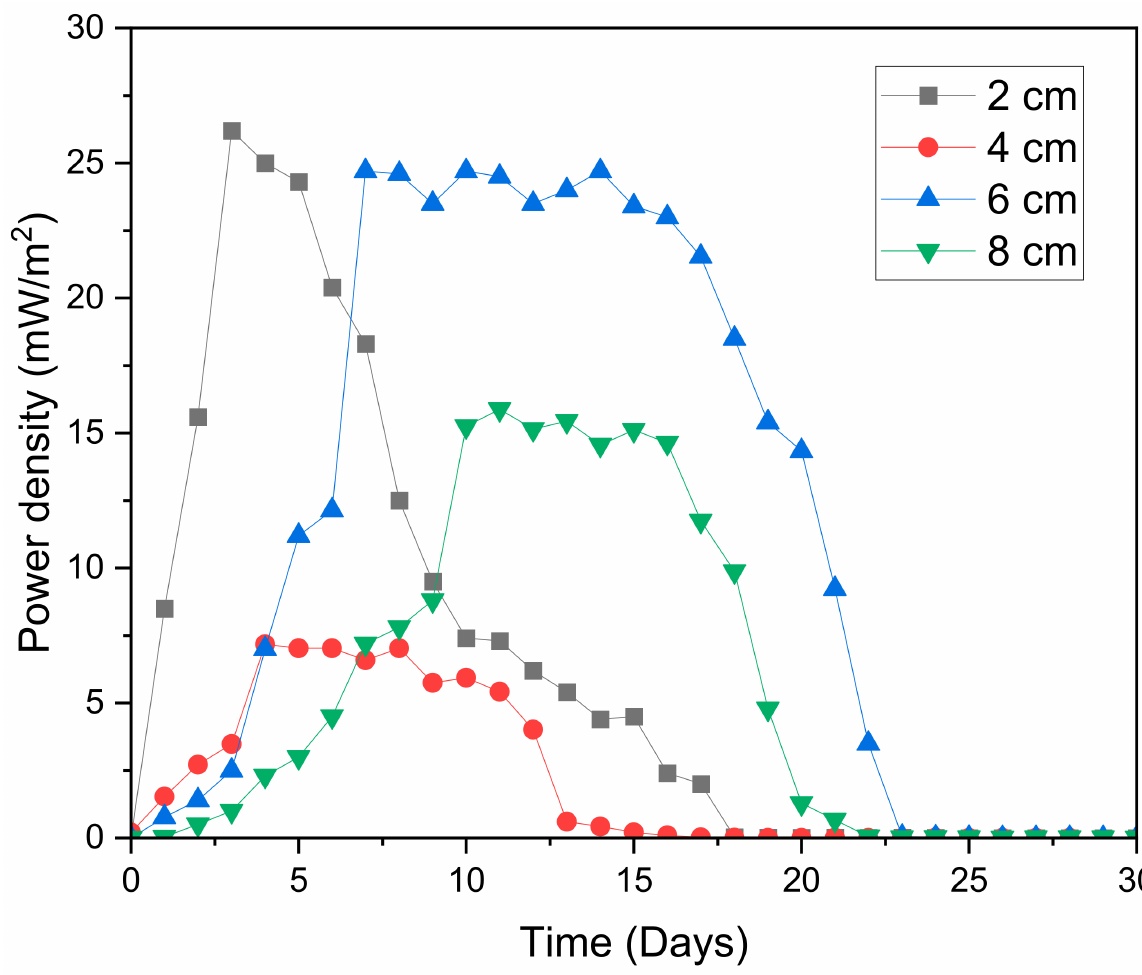
Figure 5. Power density as a function of